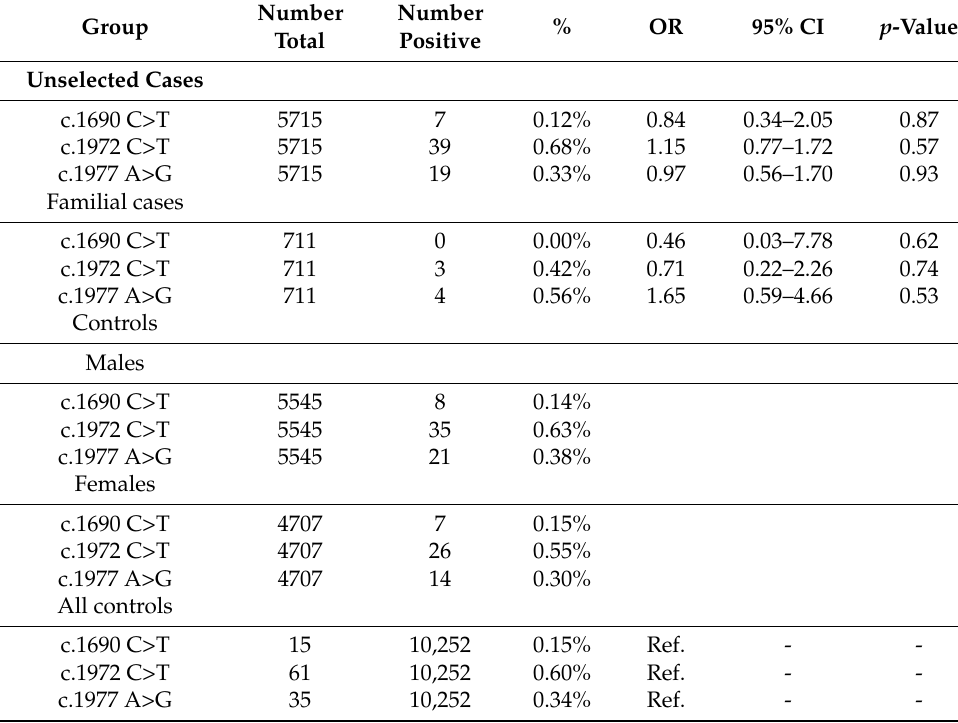
Table 1. Prevalence of BARD1 variants in 5715 patients with prostate cancer and 10,252 cancer-free controls.